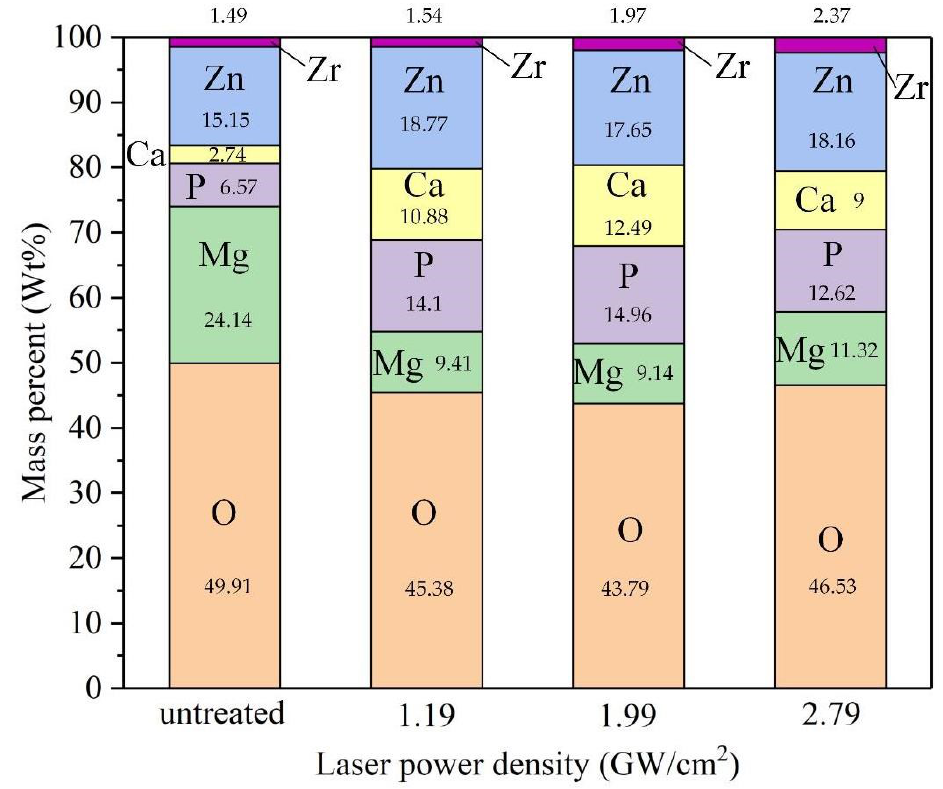
Figure 11. Elemental mass percentages of EDS spectral